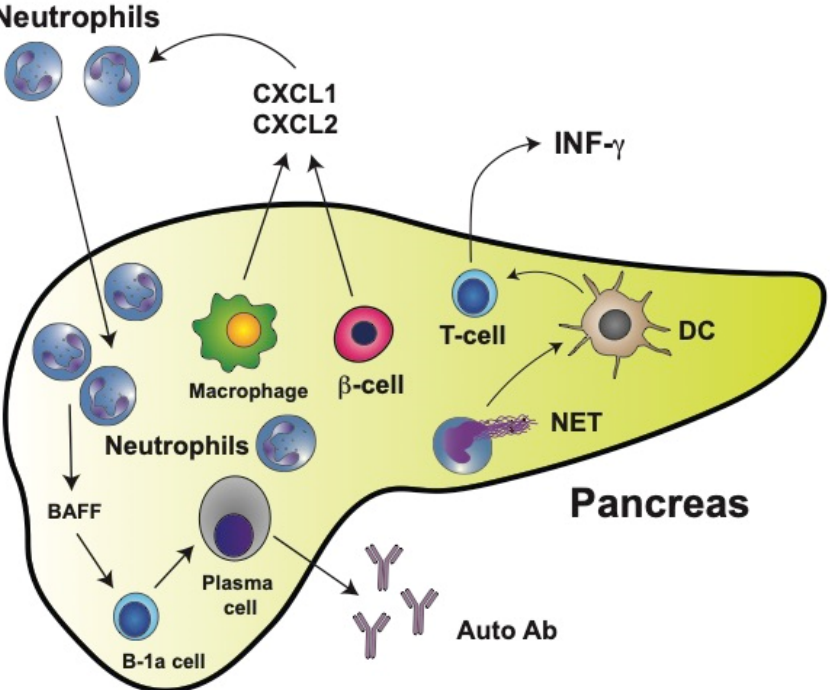
Figure 4. Type 1 diabetes mellitus (T1D) is characterized by neutrophil infiltration in the pancreas. In the pancreas, macrophages and insulin-producing β cells release chemokines CXCL1 and CXCL2, which in turn recruit neutrophils to the pancreas. Neutrophils can then directly activate B-1a cells via secreted cytokines such as BAFF (B cell-activating factor of the TNF family). BAFF is one of the main prosurvival factors for B cells as well as for antibody-producing plasma cells. Most plasma cells activated this way in the pancreas produce autoreactive antibodies (Auto Ab). The main antigens recognized by autoantibodies are glutamic acid decarboxylase (GAD), insulinoma-associated antigen-2 (IA-2), zinc transporter 8 (ZnT8), and insulin. Many neutrophils also release neutrophil extracellular traps (NET), which can activate dendritic cells (DCs). Activated DCs then stimulate T cells, leading to the production of interferon gamma (IFN- γ ).